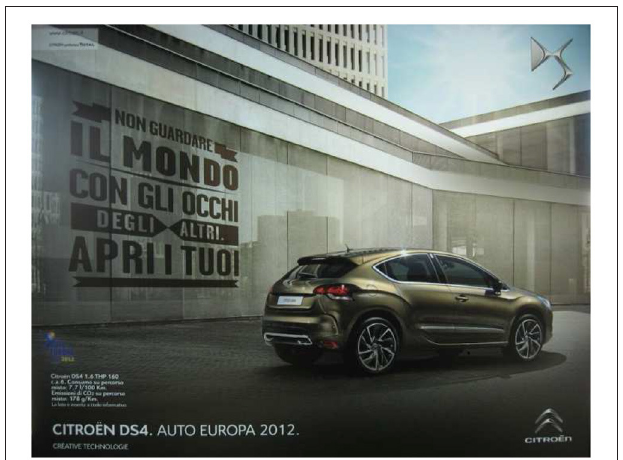
FIGURE 9 | Don’t watch the world with someone else’s eyes. Open